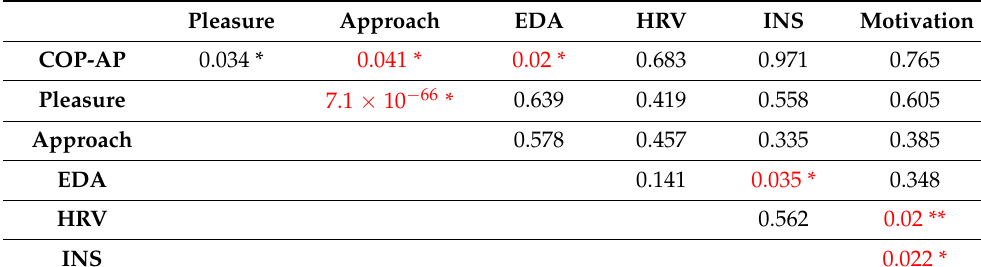
(Table 2). The subjective evaluations of the “pleasure” and “desire to approach” dimensions were correlated with the displacement of the COP-AP ( p = 0.034 and p = 0.041). The physiological data were also correlated with the posturographic parameters; the galvanic response was correlated with the displacement of the COP-AP ( p = 0.023). Table 2. Correlational table between the posturographic, subjective, physiological and psychometric data. Pleasure Approach EDA HRV INS Motivation COP-AP 0.034 * 0.041 * 0.02 * 0.683 0.971 0.765 Pleasure 7.1 × 10 − 66 * 0.639 0.419 0.558 0.605 Approach 0.578 0.457 0.335 0.385 EDA 0.141 0.035 * 0.348 HRV 0.562 0.02 ** INS 0.022